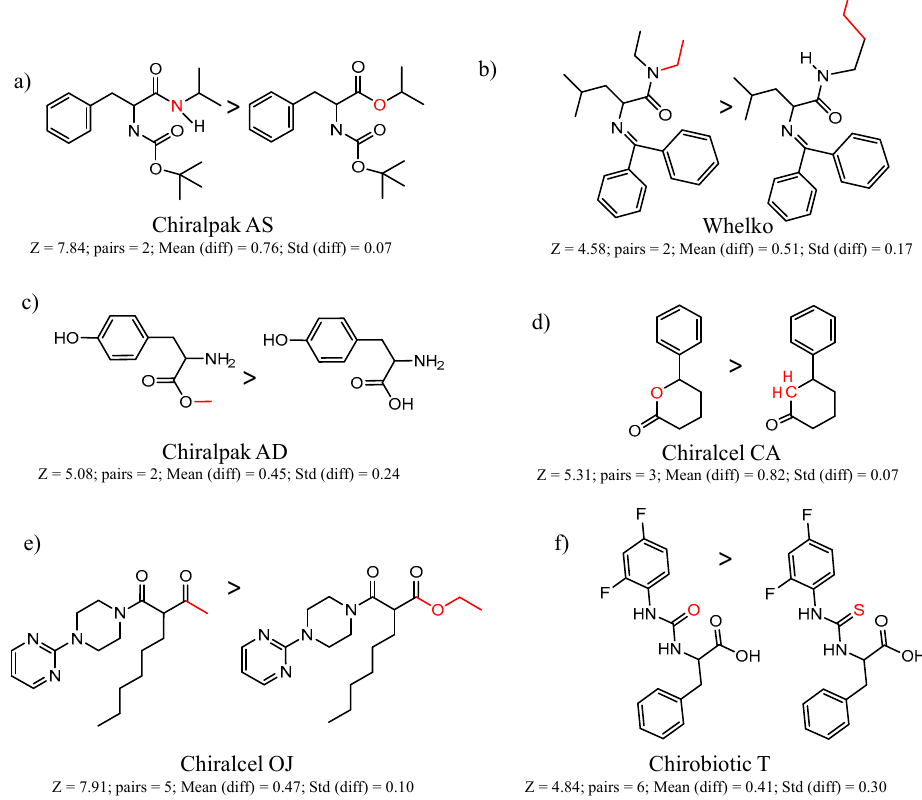
Figure 4. Matched Molecular Pairs illustrating effects of hydrogen bonding on chiral recognition.